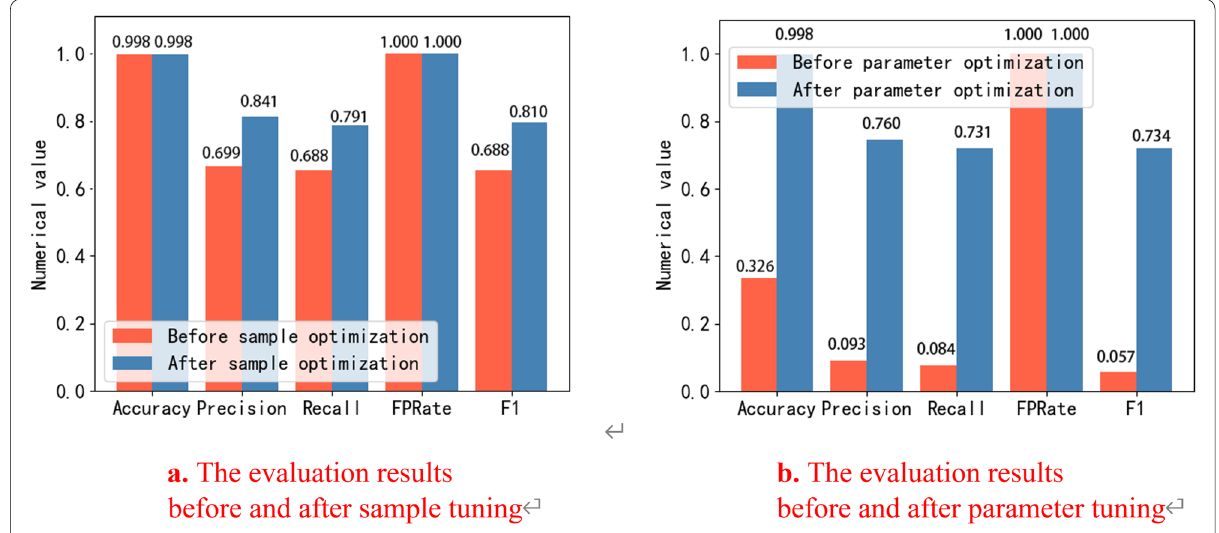
Fig. 9 Comparison of samples and parameters before and after adjustment